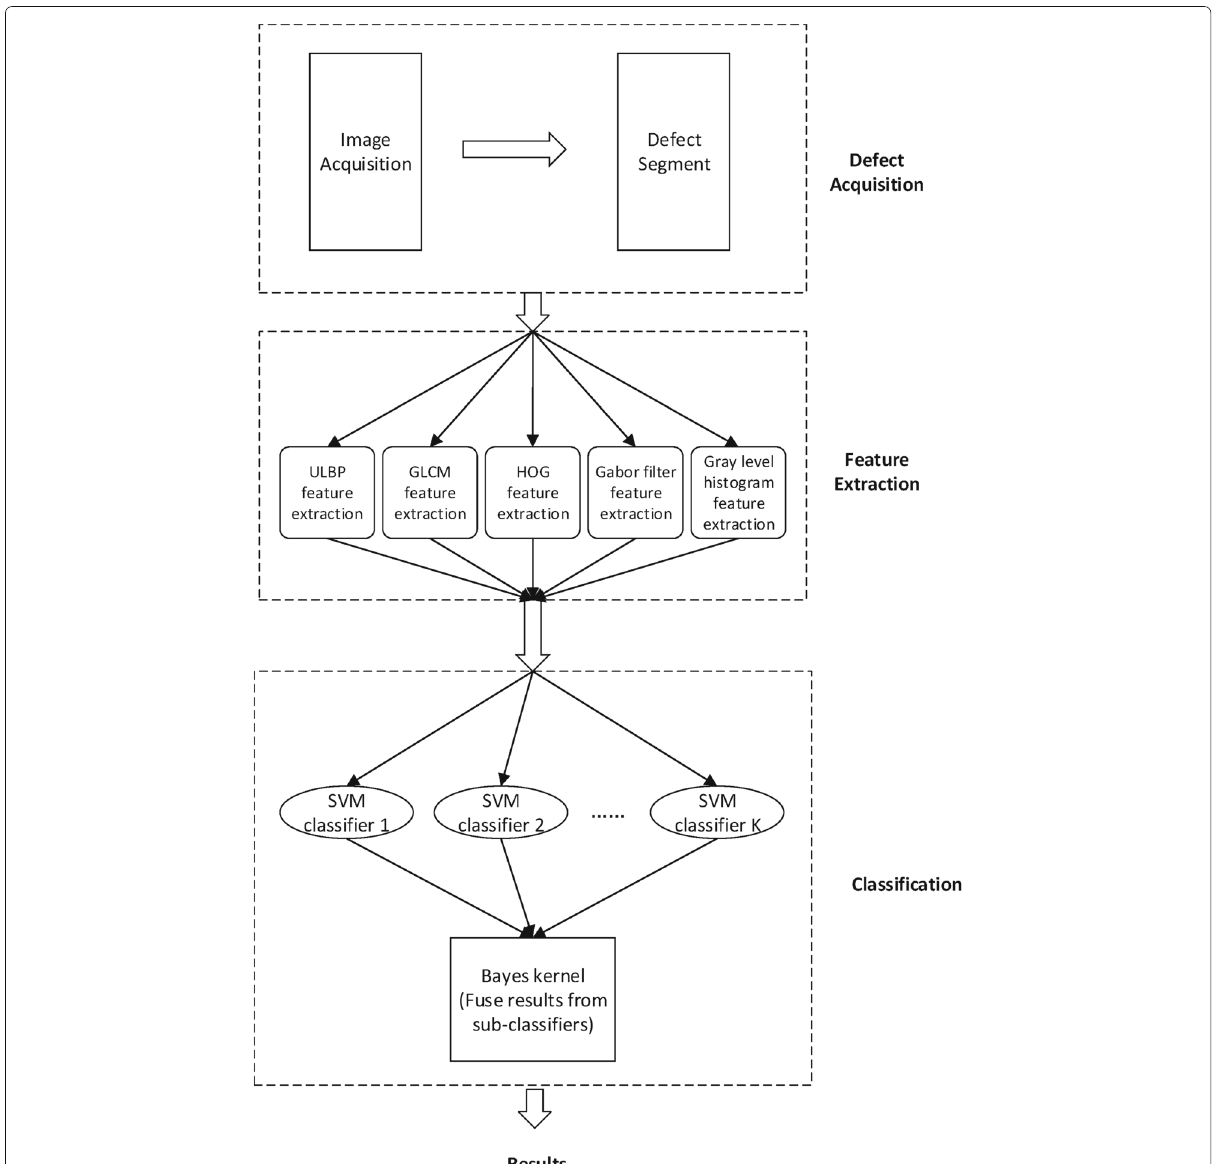
Fig. 1 Structure of the evolutionary classifier for steel surface defects using a Bayes kernel